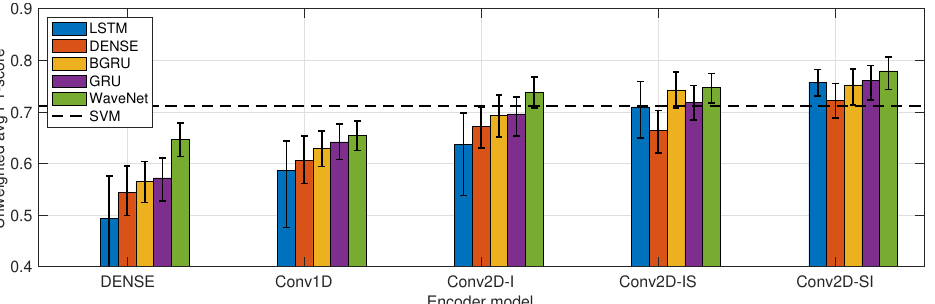
Figure 5. Unweighted average F 1-scores as a function of encoder modules (x-axis placement) and time series modules (color coding). The 95% confidence intervals obtained with the bootstrap method (record-level sampling, 10,000 iterations) are presented as whiskers.